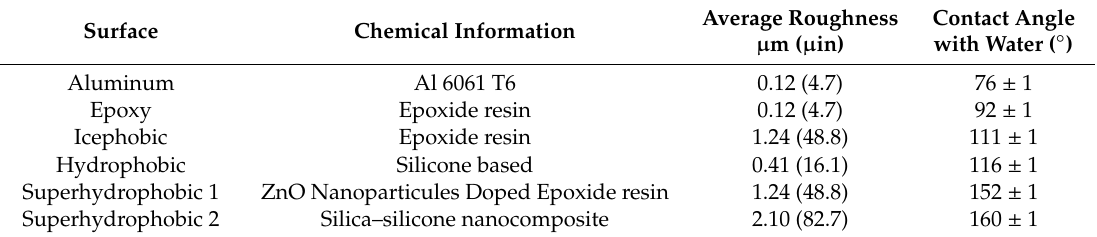
Table 3. Surface roughness and contact angles with water for the different surfaces.